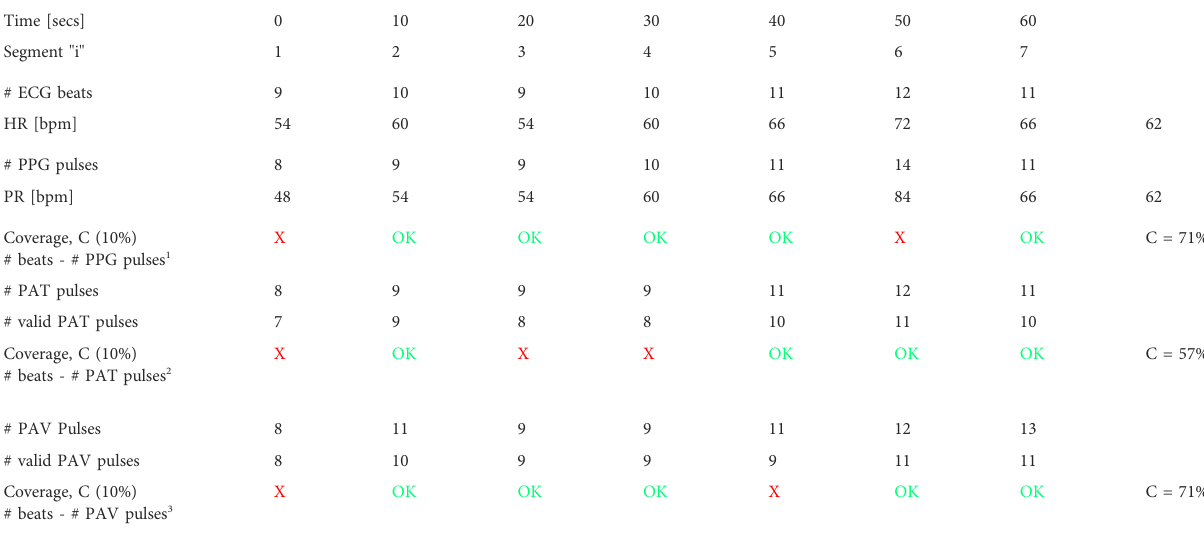
TABLE 1 Illustrative example for the coverage de fi nition. For the PR, good coverage is considered in a 10-s segment if the estimation error of PPG pulses is lower than 10% compared to ECG. For PAT-coverage measurement purposes, a 10-s segment is considered valid if the number of PAT values differs by less than 10% from the number of ECG beats. Note that PAT measures may be omitted either because of being considered out of physiological limits or because the associated PPG pulse is considered spurious. Similar to PAT, this is done for the PAV-coverage measurement.